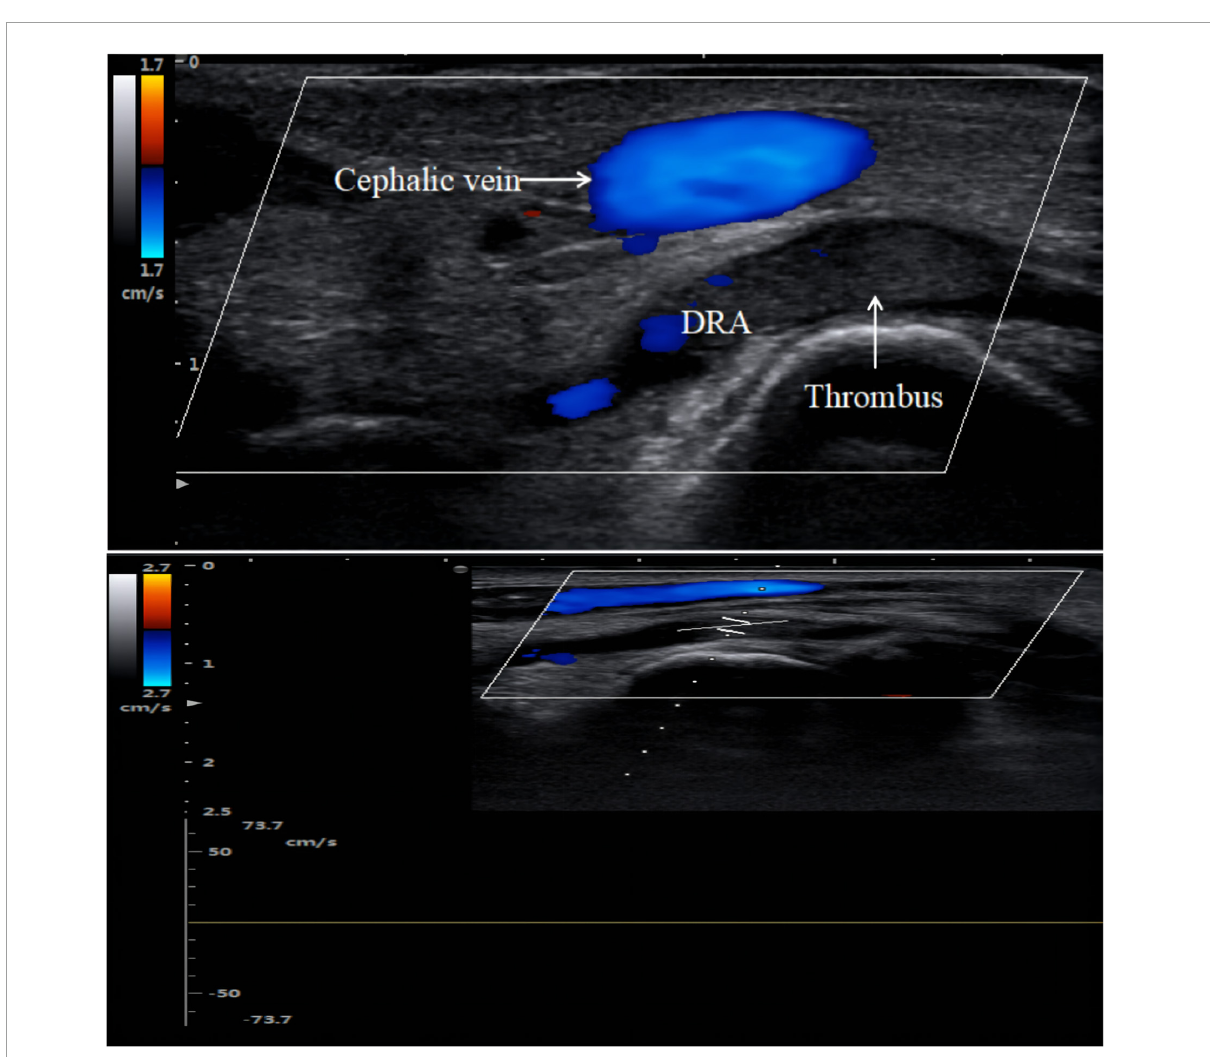
FIGURE5 Distal radial artery occlusion. Thrombus is hypoechoic on color Doppler imaging. There is no blood flow spectrum waveform curve on pulse wave Doppler